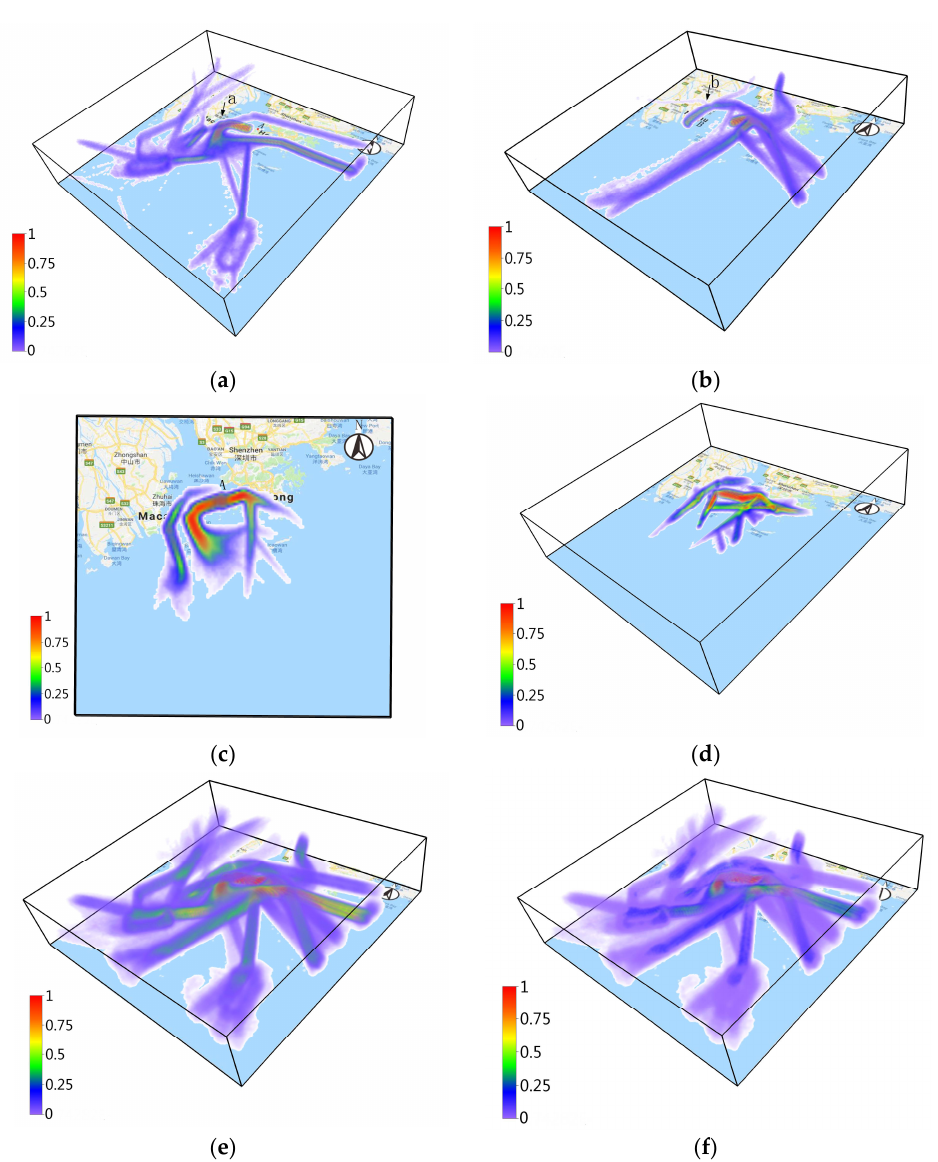
Figure 6. Time density volume of flight movement trajectory at VHHH and VMMC. TotalTimeDensity volume of ( a ) arrival flights and ( b ) departure flights shown with direct volume rendering. TotalTimeDensity volume of flight movement trajectory shown with ( c ) a horizontal clipping plane and ( d ) multiple clipping planes in different orientations. Density volume of ( e ) the number of visits and ( f ) AverageTimeDensity.